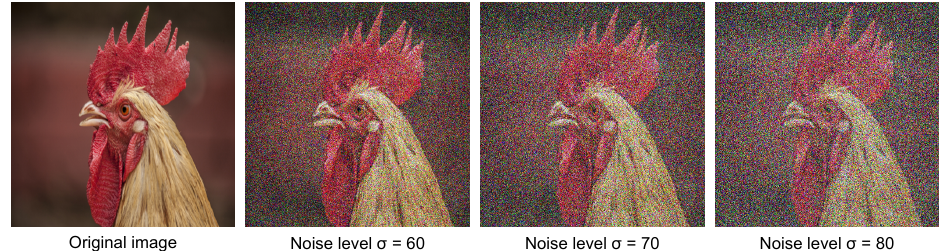
Figure 4. Example of “chicken” image with three noise